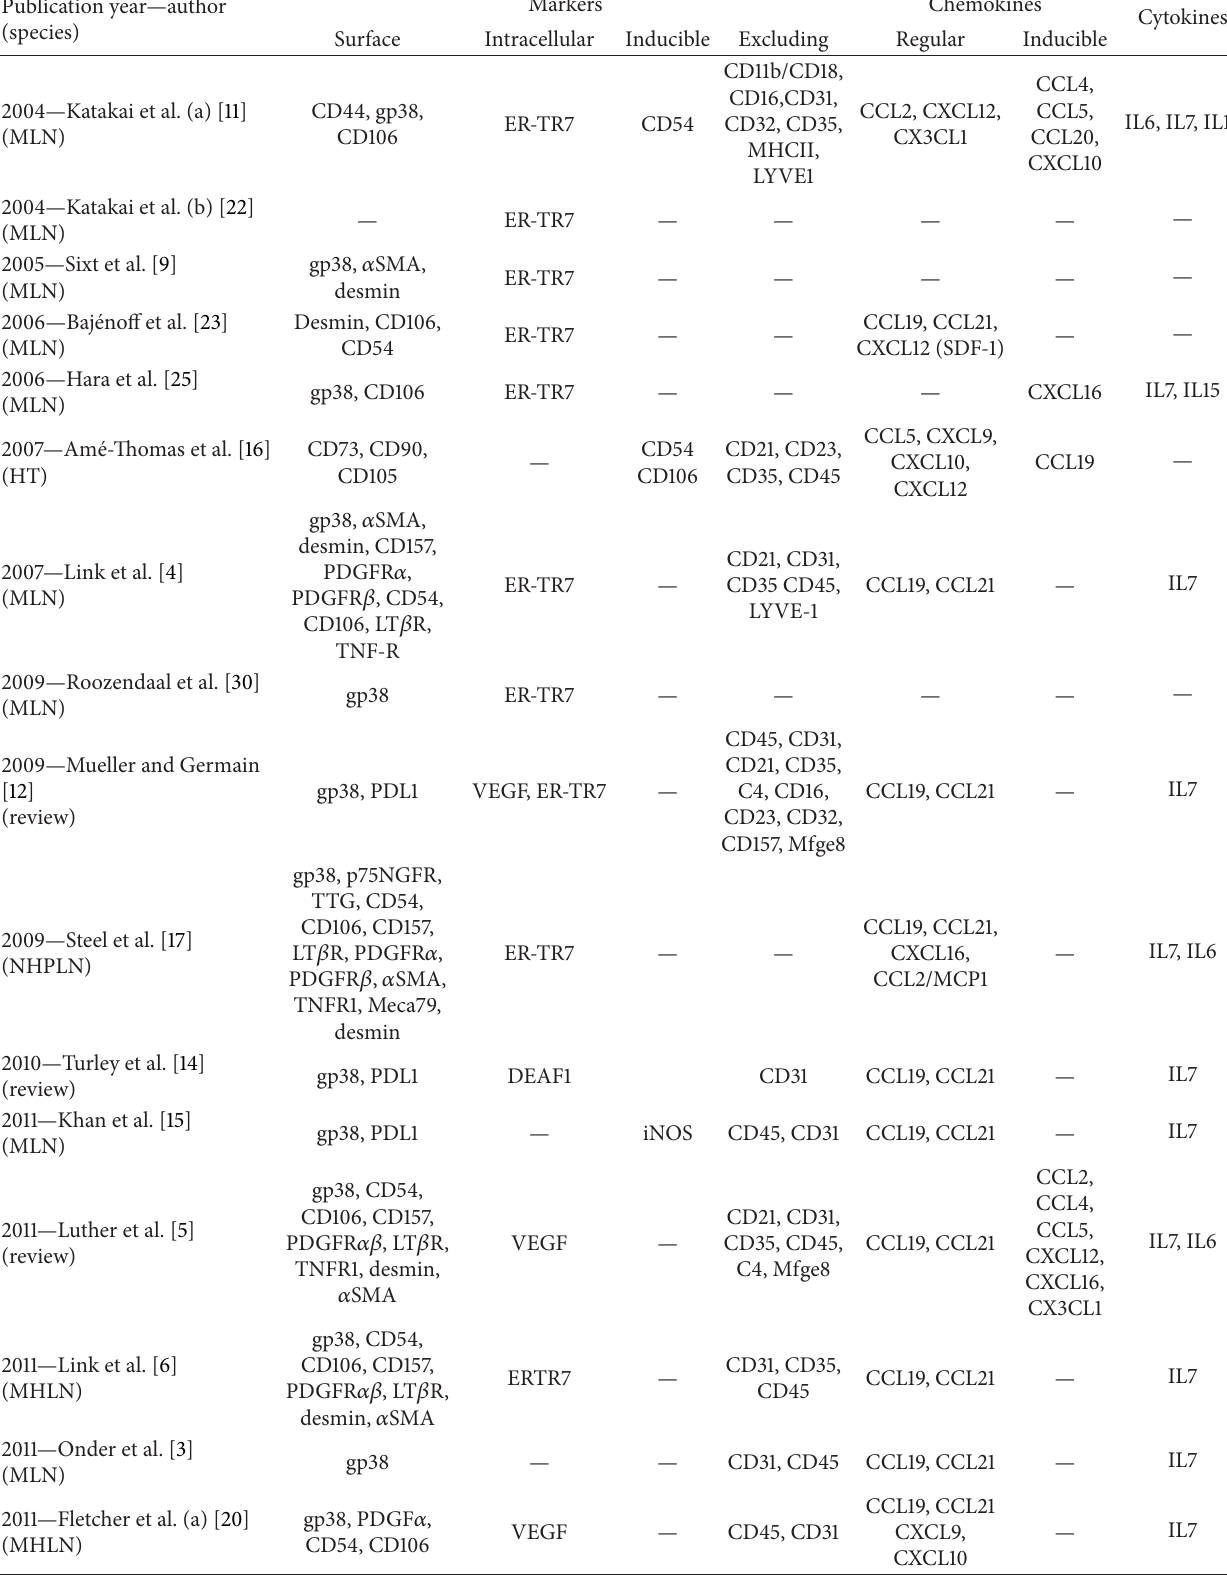
Table 1: FRC characterization markers. FRC was classified by species, surface or intracellular makers, inducible markers and ones that exclude other cells presence, and chemokines and cytokines secretion, listed in time order of